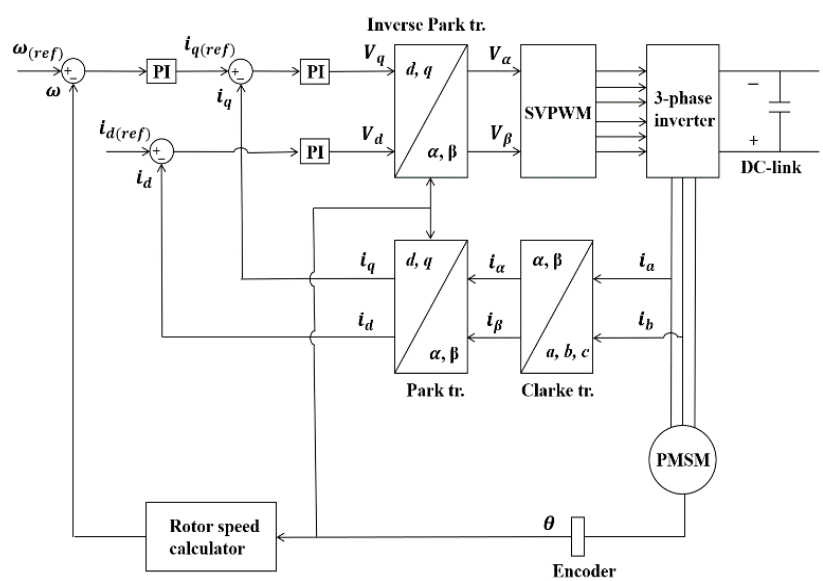
Figure 1. Vector Control Scheme.